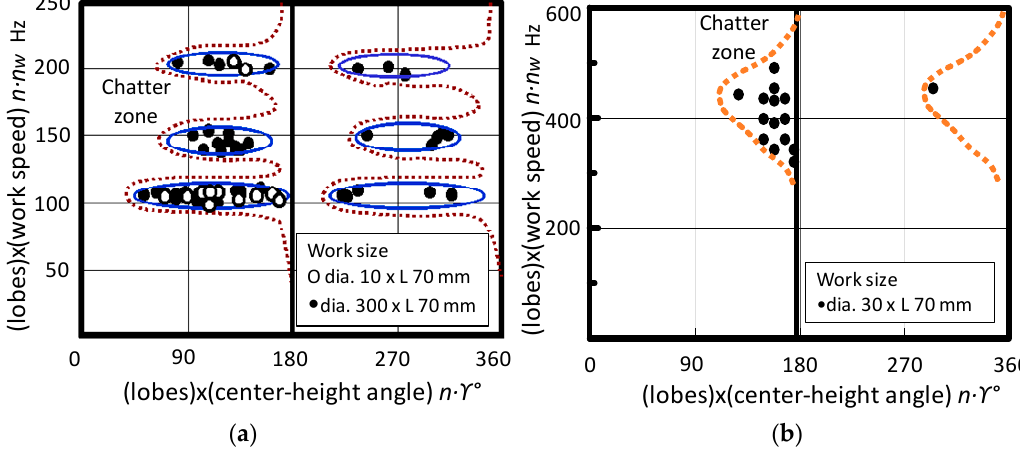
Figure 14. Chatter zones on ( n· γ –n·n w ) diagram. ( a ) Grinding machine A; ( b ) Grinding machine B.